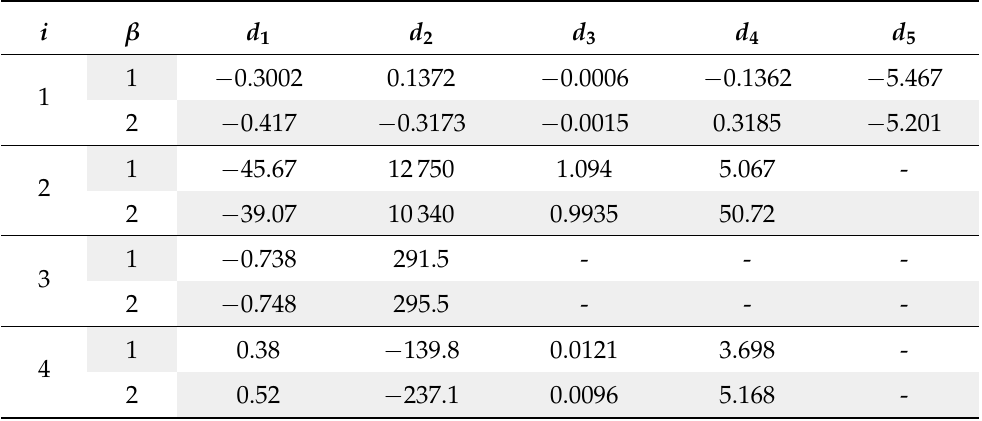
Table 6. Coefficient values for parametric expressions of the functions (cid:98) c (cid:98) c 1 , . . . , (cid:98) c 4